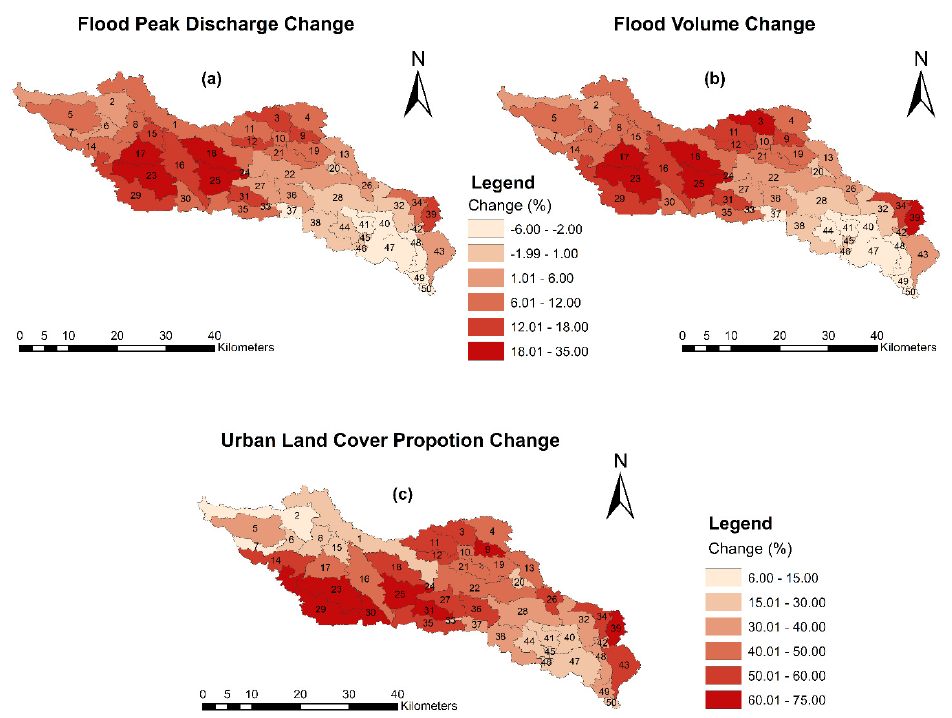
Figure 8. Spatial variations of flood peak discharge ( a ), flood volume ( b ), and spatial distribution of relative change in urban land cover ( c ) between 1986 and 2017 at the sub-basin scale.